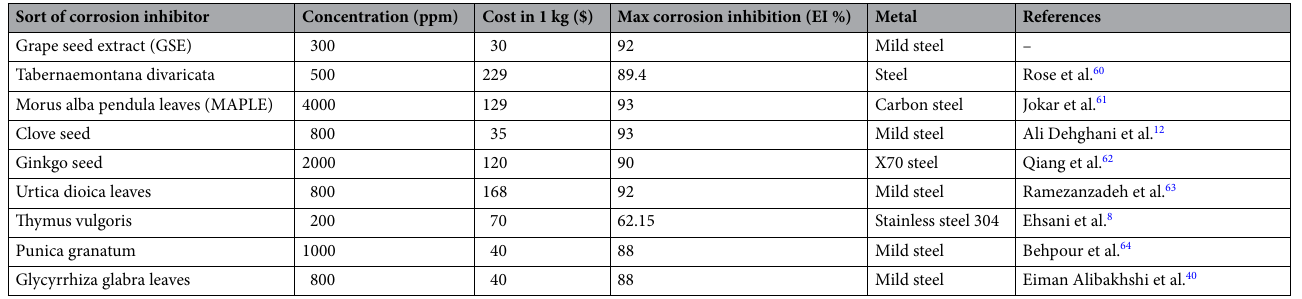
Table 5. Comparison of the price and inhibition efficiency of the plant extracts in hydrochloric acid